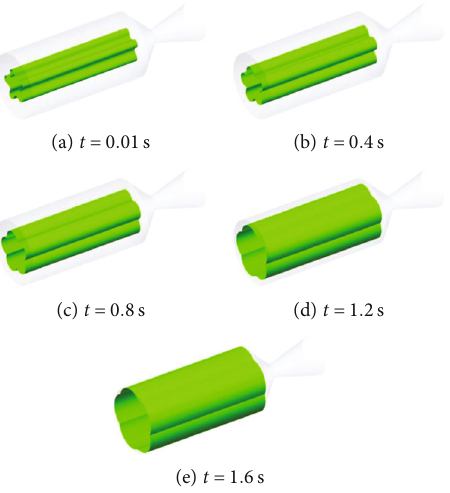
Figure 13: Schematic diagram of burning surface